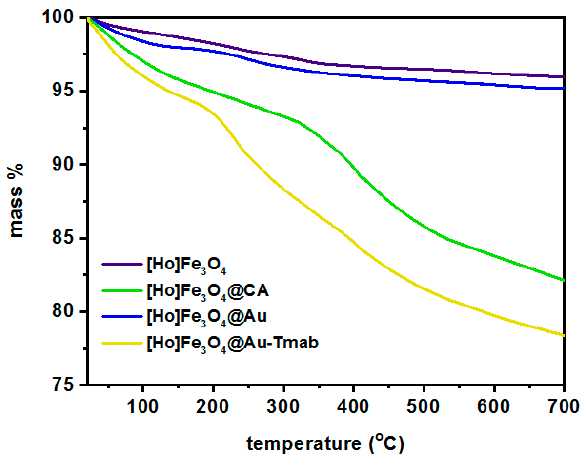
Figure 6. Thermograms of [Ho]Fe 3 O 4 , [Ho]Fe 3 O 4 @CA, [Ho]Fe 3 O 4 @Au, and [Ho]Fe 3 O 4 @Au ‐